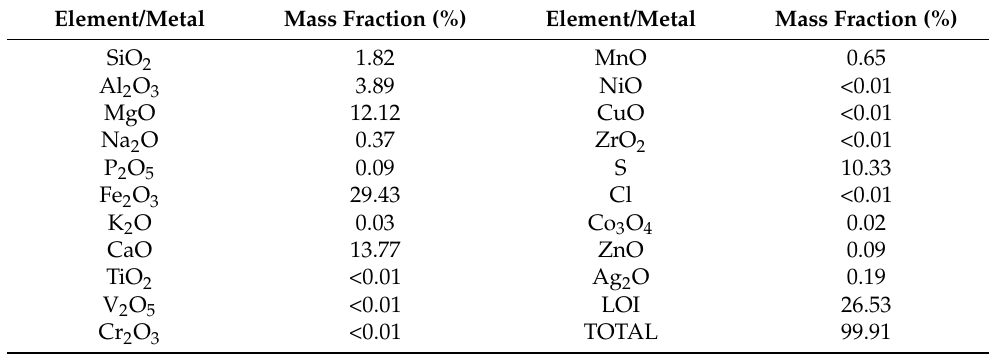
Table 2. The elemental composition (wt.%) of the product sludge as determined by the XRF technique.